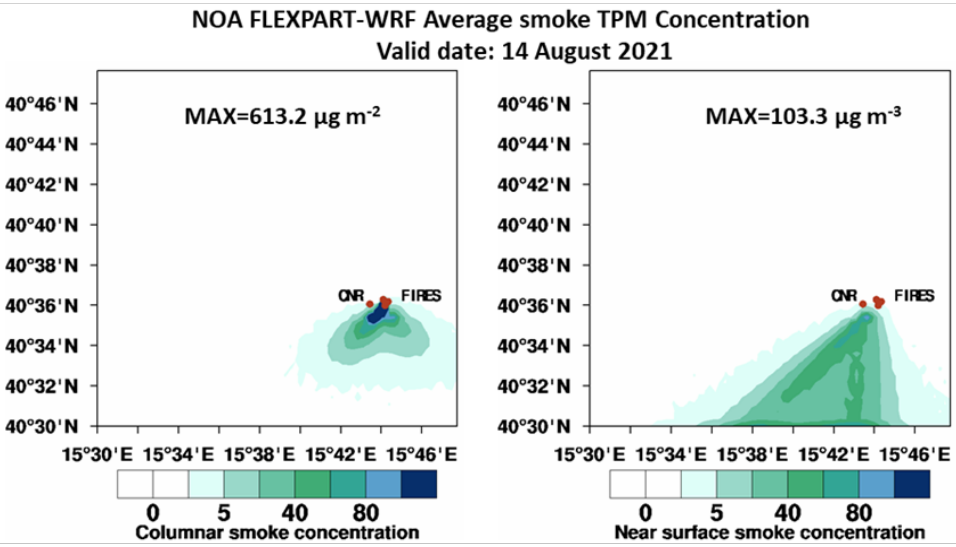
Figure 3. Simulated FLEXPART ò − WRF average smoke TPM concentration ( left ) columnar concentration ( µ g m − 2 ) and ( right ) smoke concentration ( µ g m − 3 ) at the first model layer on 14 August 2021.